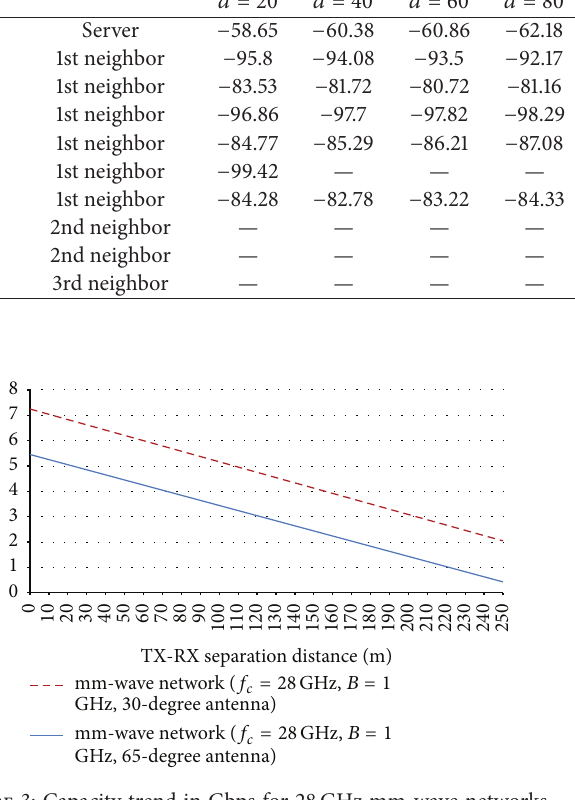
Table 2: Carrier and interference measurements for 28 GHzmm-wave networks using 30 ∘ beamwidth TX antennas for the trisector BS’s. Site ID Server/neighbor